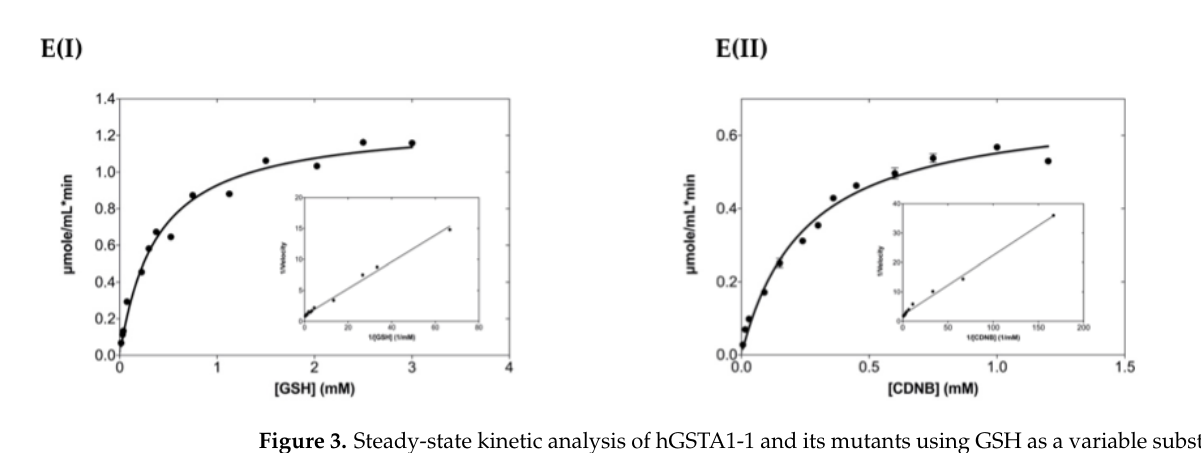
Figure 3. Steady-state kinetic analysis of hGSTA1-1 and its mutants using GSH as a variable substrate (I) and CDNB at a fixed concentration. Steady-state kinetic analysis of hGSTA1-1 and its mutants using the CDNB as a variable substrate (II) and GSH at a fixed concentration. ( A ) hGSTA1-1, ( B ) hGSTA1- K141H, ( C ) hGSTA1-K141H/S142H, ( D ) hGSTA1-E137H, and ( E ) hGSTA1-E137H/K141H. Experi- ments were performed in triplicate. The inside graphs are the Lineweaver-Burk plots.